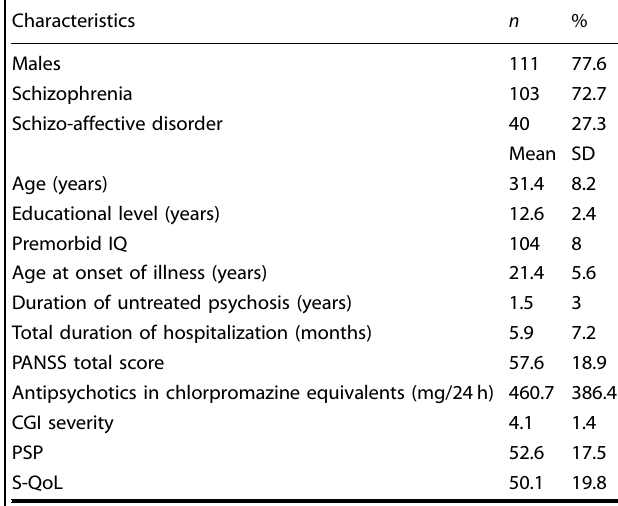
Table 1. Baseline clinical characteristics of the